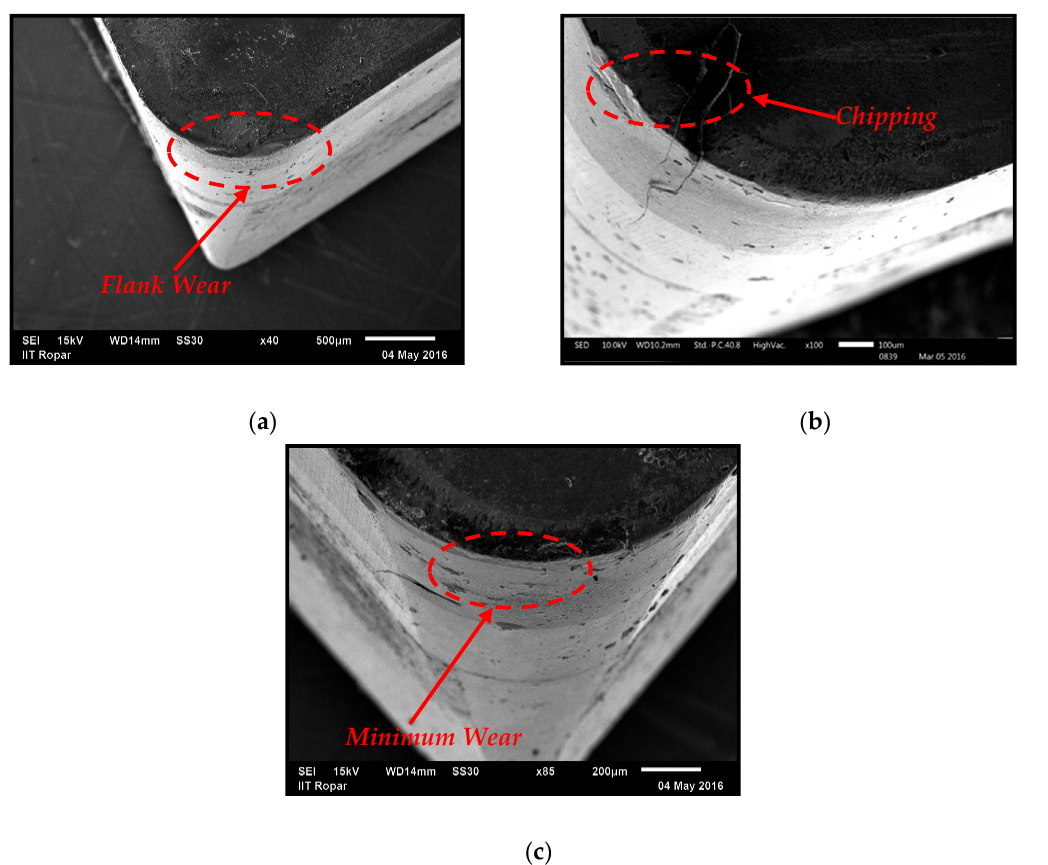
Figure 7. Tool wear images at different working conditions at V c = 300 m/min, f = 0.15 mm/rev, ap = 0.50 mm. ( a ) Al 2 O 3 nanofluid; ( b ) MoS 2 nanofluid; ( c ) Graphite nanofluid.